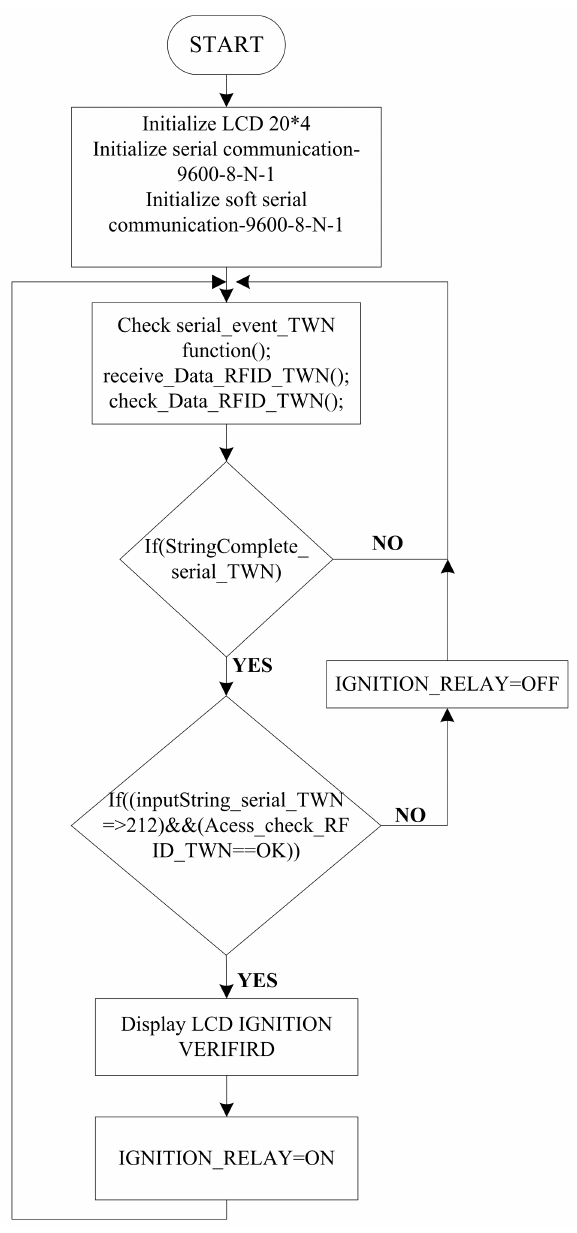
Figure 10. Flow chart for the two-wheeler